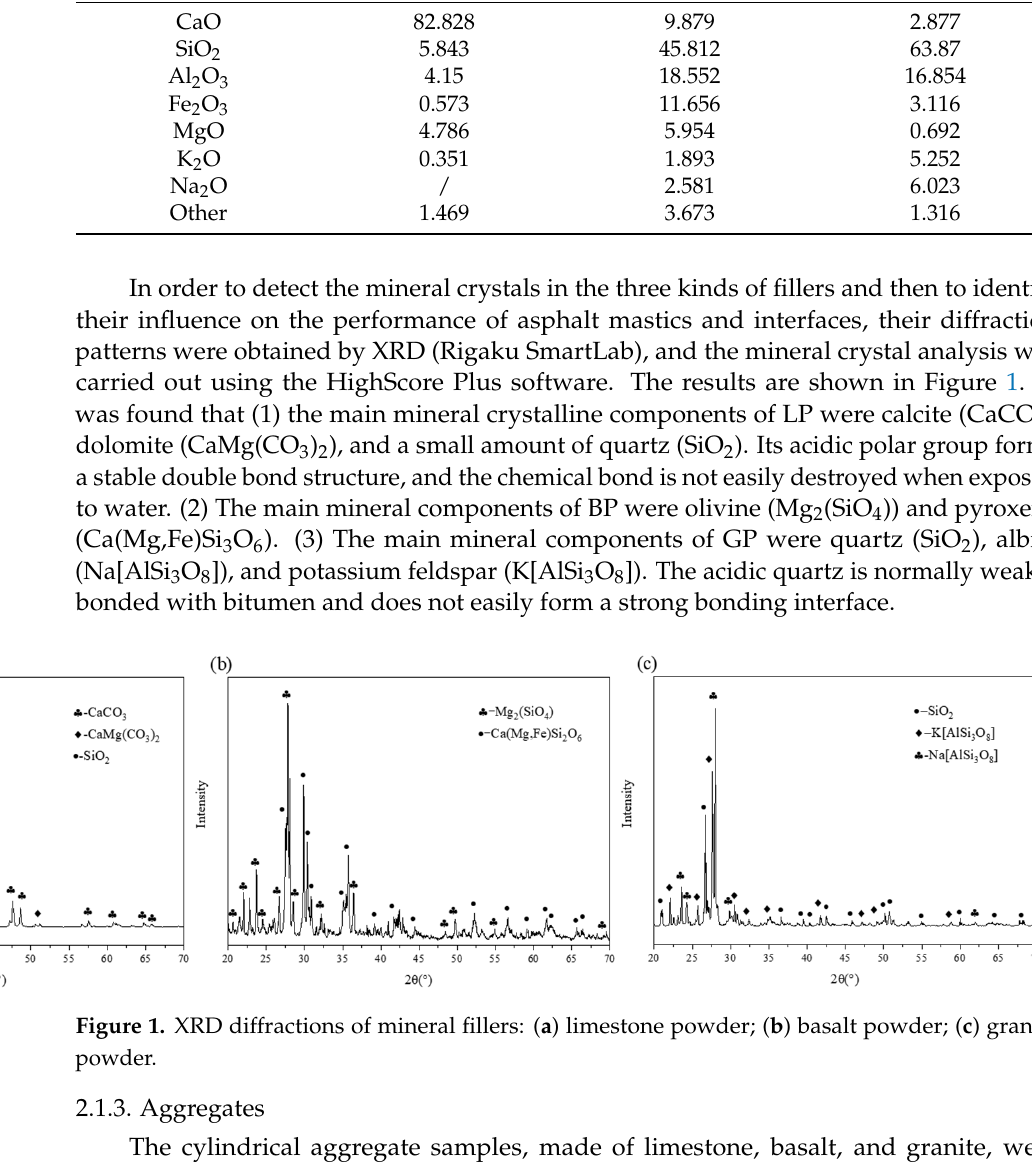
Table 4. Oxide composition of mineral fillers (%).